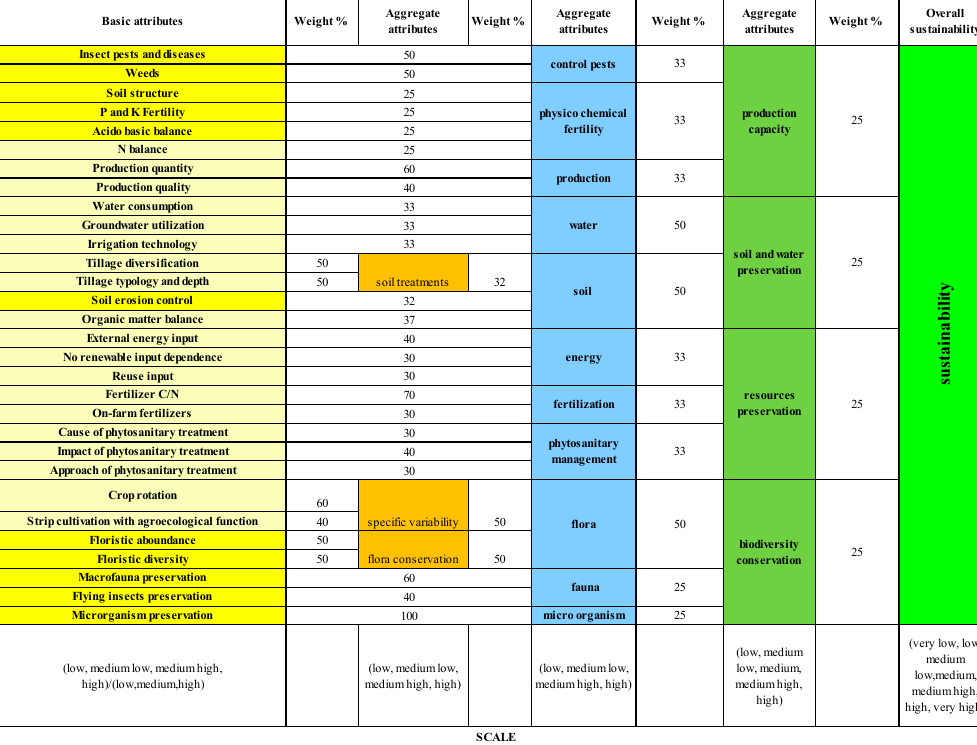
Figure 3. New multi-criteria model (DEXi-met) decision tree. Different colors represent different attribute levels, i.e., 30 basic attributes (in yellow; light yellow if generated by satellite trees), aggregate attributes at different levels (orange and light blue), four nodal attributes (olive green) and overall sustainability (green). The numbers between attribute levels represent the default aggregation weights (expressed in %). For each attribute level (basic, aggregate, and overall), the scale is shown at the bottom of the figure.